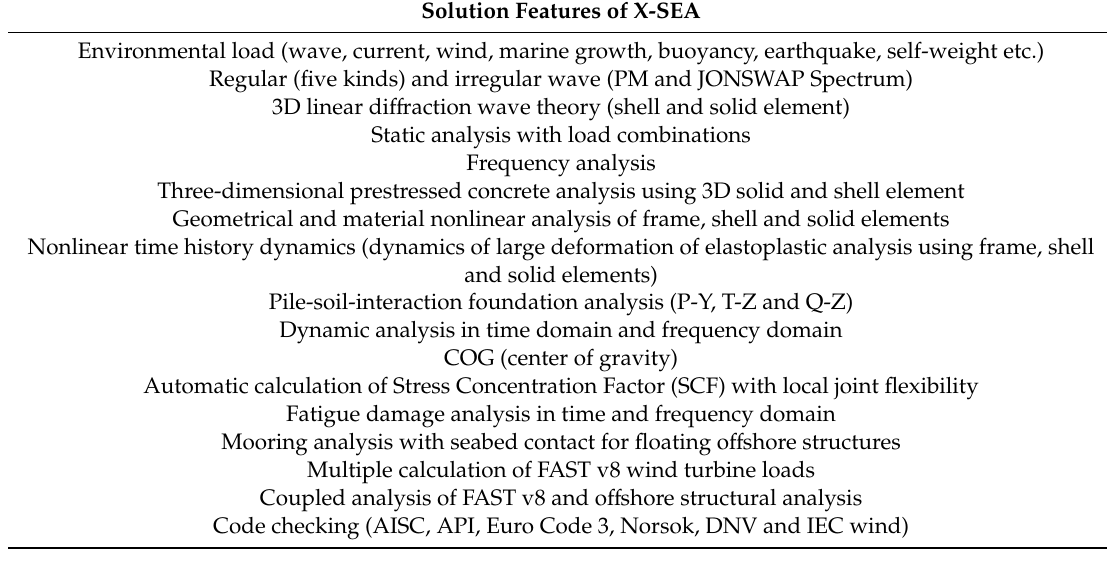
Table 2. Element Library of